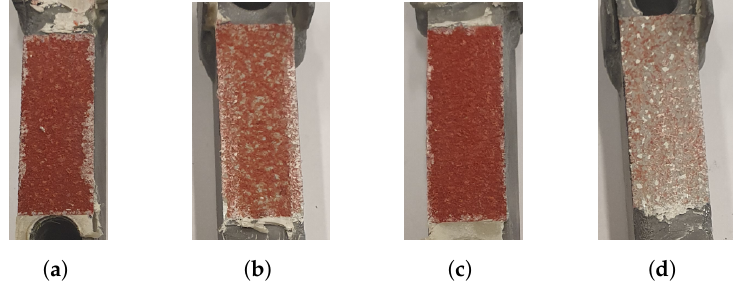
Figure 16. The fractured cores of two specimens, subjected to LC 3, are presented. ( a , c ) contain the lower skins and ( b , d ) contain the upper